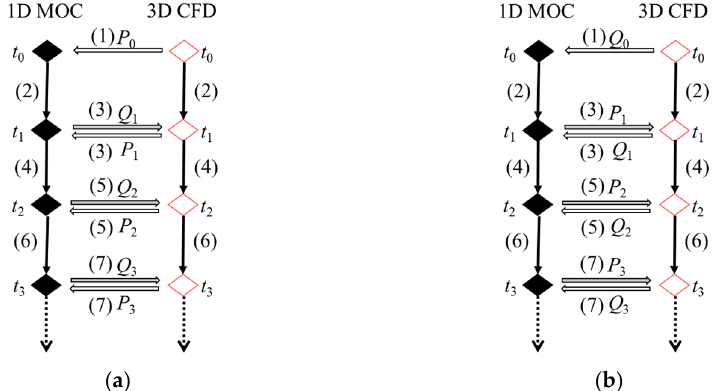
Figure 5. Coupling interface data transfer mechanism. ( a ) Turbine inlet coupling interface. ( b ) Turbine outlet coupling interface.